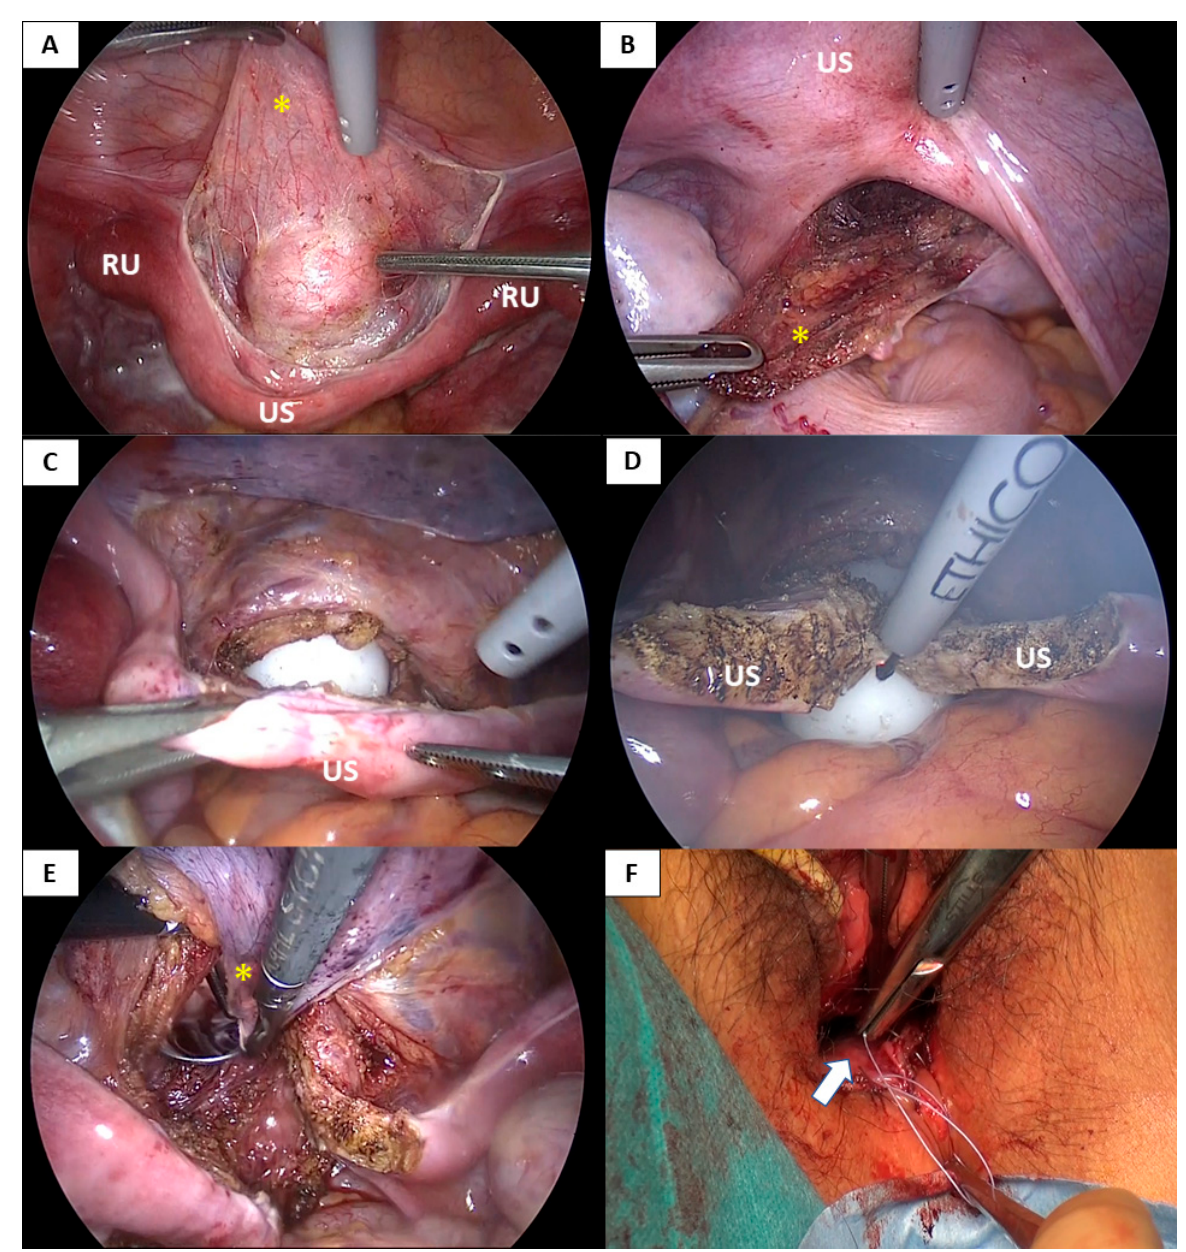
Figure 2. Laparoscopic pull-down technique of the peritoneal flaps with uterine strand incision. ( A ) The supravesical peritoneum (anterior peritoneal flap) (*) along the uterine strand and the bilateral rudimentary uteri is dissected from the bladder. ( B ) The peritoneum of the pouch of Douglas below the uterine strand is incised transversely and mobilized to create the posterior peritoneal flap (*). ( C ) A dilator is inserted through the dissected vaginal space and the apex of the vault is opened with a transverse incision below the strand. ( D ) A longitudinal incision is made in the middle of the uterine strand, dividing the uterine strand bilaterally. ( E ) The edges of the anterior (*) and posterior peritoneal flaps are pulled through the newly created canal under laparoscopic assistance. ( F ) The anterior and posterior flaps are sutured to the anterior and posterior mucosa of the neovaginal introitus. US; Uterine strand, RU; Rudimentary uterus.